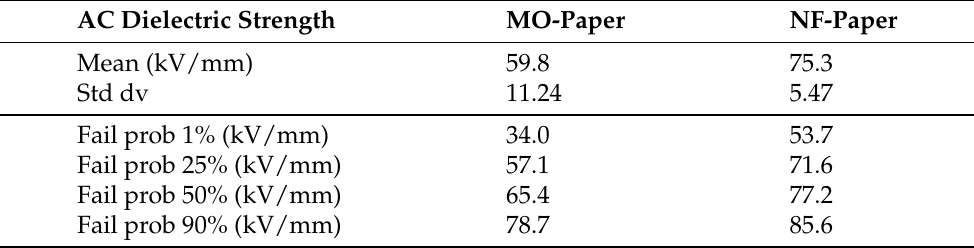
Table 3. Statistic analysis of the AC dielectric strength tests for both types of